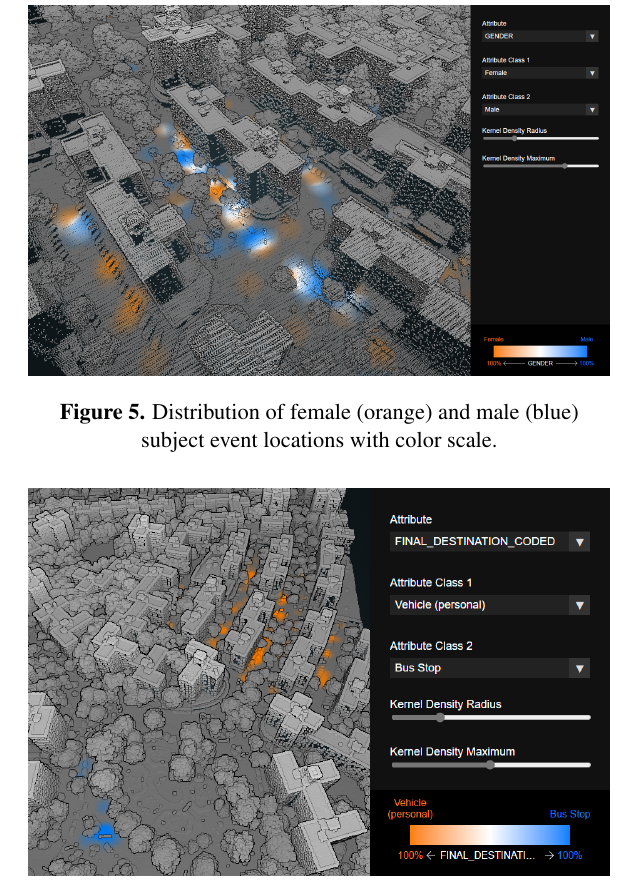
Figure 6. Event location distribution by a multi-class attribute: transportation choice destinations of subjects by private vehicle (orange) or bus stop (blue), with user control panel in detail. Microsoft Edge 93.0.961.44 at a 1440x720 window size